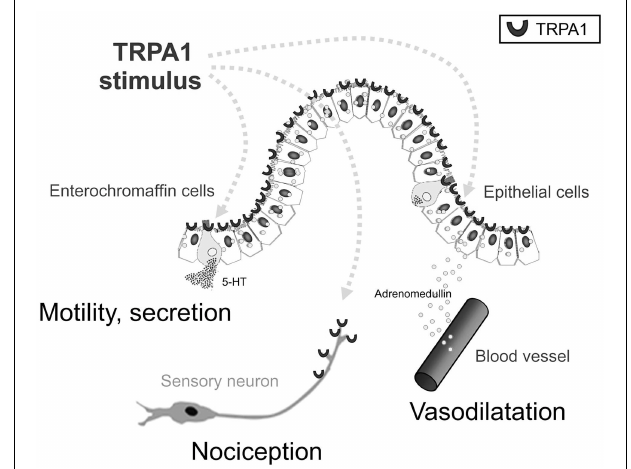
FIGURE 2 | Diagrammatic representation of the hypothesized journey of TU-100 compounds after ingestion. The concentrations of TU-100 compounds and their conjugates after oral administration of TU-100 in rat intestinal, portal blood and peripheral blood and in human ileal effluent and peripheral blood were measured in several PK studies (Munekage et al., 2011, 2013; Watanabe et al., in press). The results are summarized as indicated in the figure. The diagram of digestive sysytem (A) , and the fate of Japanese pepper (B) , Ginger (C) and ginseng (D) ingredients are shown. The effect of TU-100 on the intestines should be a composite of multiple actions by multiple compounds supplied via multiple routes. Quoted from Watanabe et al. (in